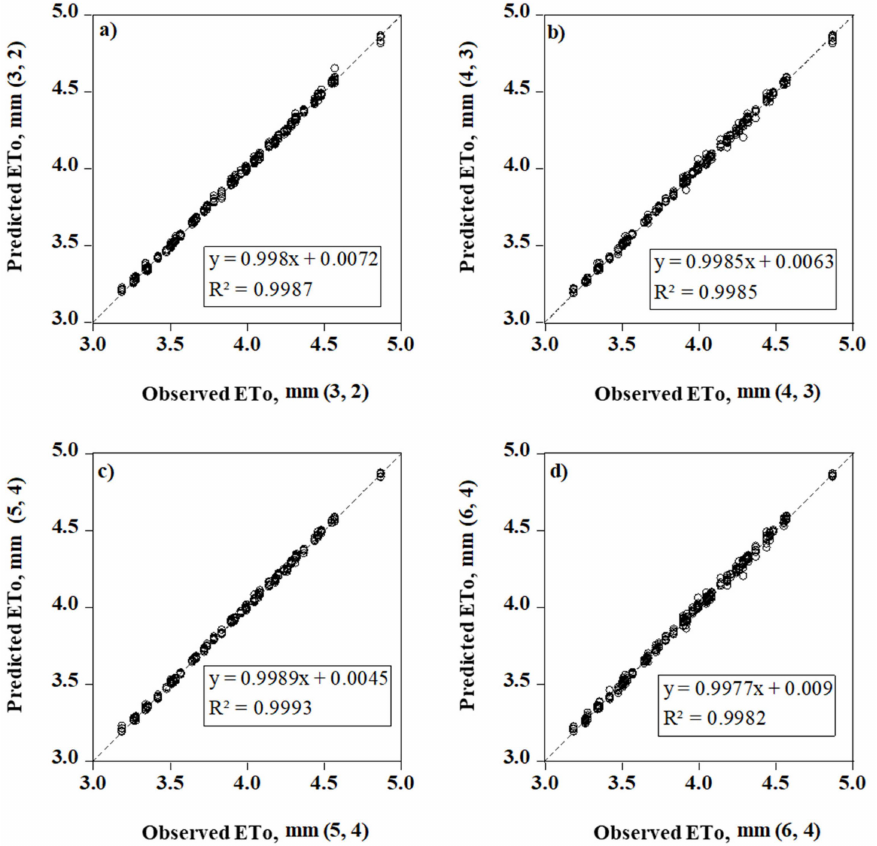
Figure 5. Comparison between model prediction and observed ET o values for the optimal ANNs at the different hidden layers for Debrecen ( a ) performance of model with hidden layers (3, 2); ( b ) performance of model with hidden layers (4, 3); ( c ) performance of model with hidden layers (5, 4); ( d ) performance of model with hidden layers (6,